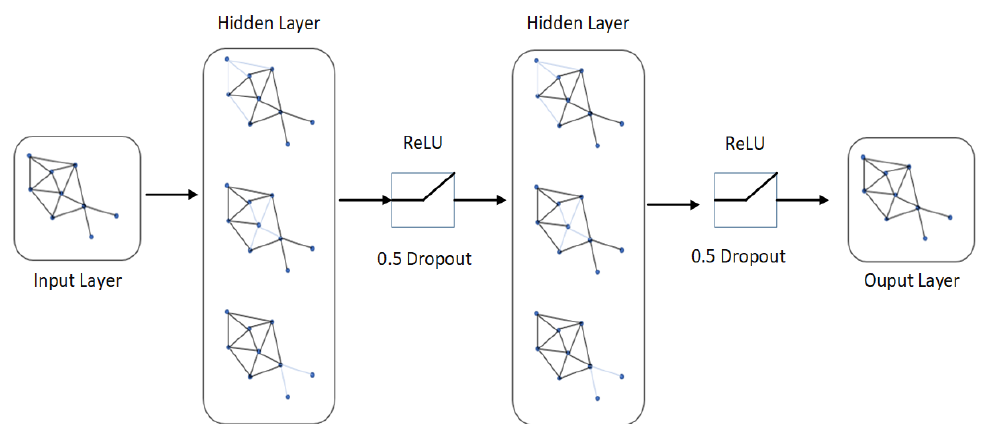
Figure 3. Dynamically update graph on each layer using random dropout which is 0.5 in our case and ReLU as an activation function. The output layer concatenates all the edge features into global shape